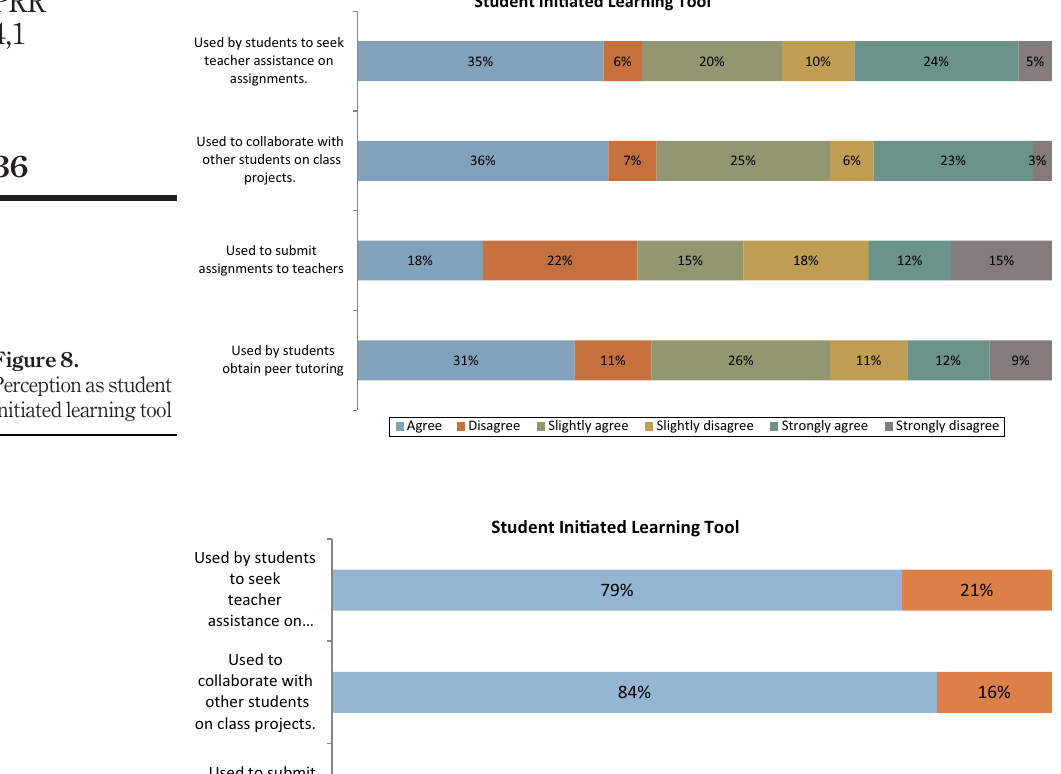
Figure 9. Favorable vs unfavorable response – student initiated learning tool